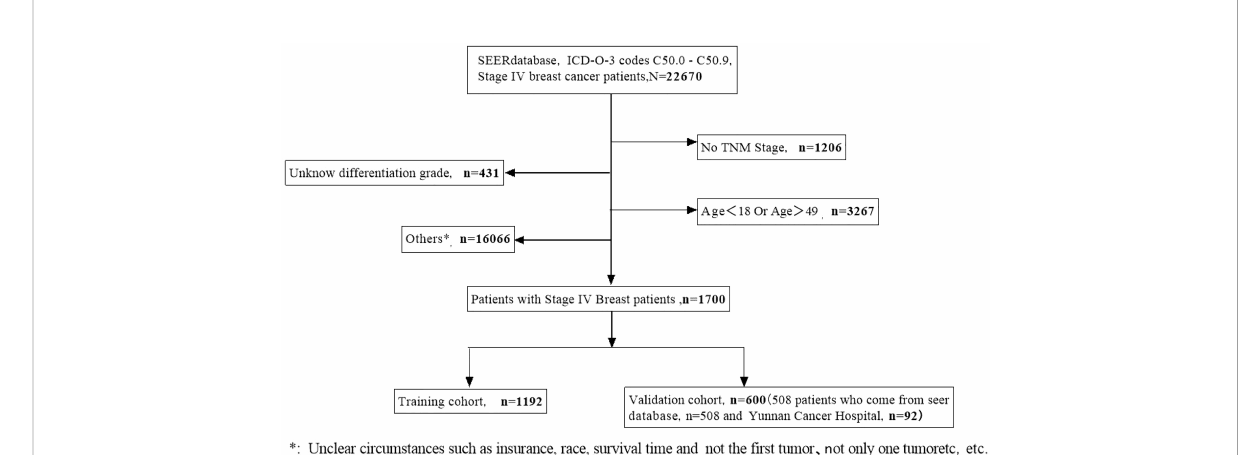
FIGURE 1 A fl ow diagram showing the screening process for the analysis of patients in the SEER and Yunnan